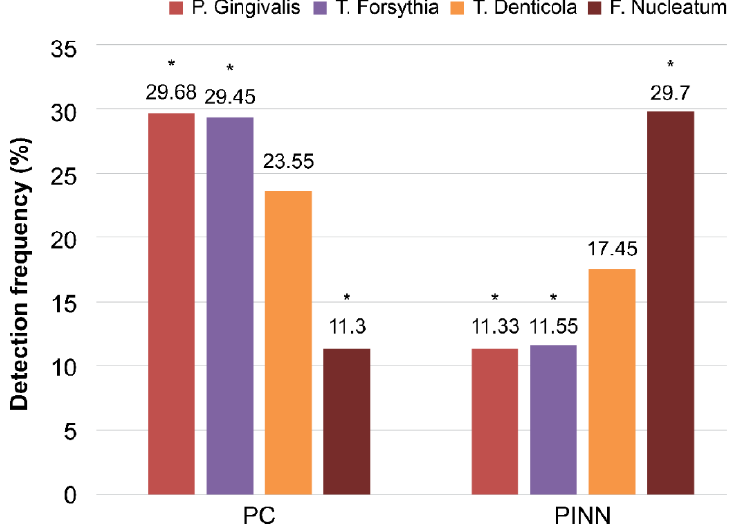
Figure 3. Comparison between control subjects with generalized periodontitis stage I (PC) and subjects with generalized periodontitis stage I receiving isotretinoin (INN) (PINN) in the detection of bacterial pathogens. * statistically significant.